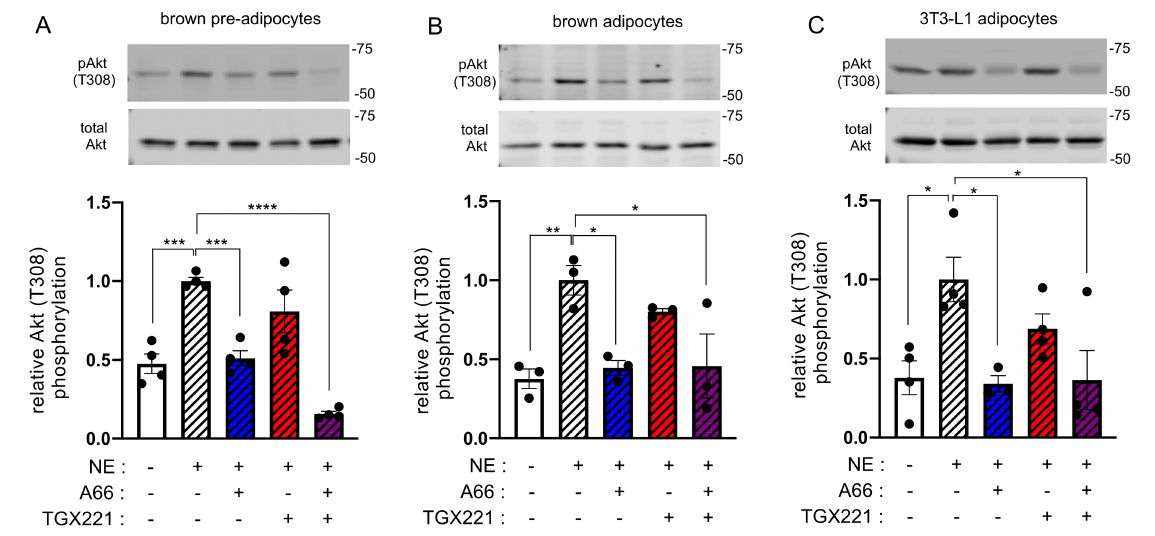
Figure 4. p110 α is the principal PI3K isoform engaged in β -adrenergic signalling in adipocytes. Brown pre-adipocytes ( A ) or differentiated adipocytes ( B ) or differentiated 3T3-L1 adipocytes ( C ) were treated with A66 (1 µ M, blue graph bars) or TGX221 (0.5 µ M, red graph bars) or a combination of both inhibitors (purple graph bars) followed by stimulation with 1 µ M of norepinephrine (NE, striped graph bars) for 15 min at 37 ◦ C. Levels of Akt T308 phosphorylation were determined by immunoblot analysis. Phosphorylation levels were normalised to total Akt levels detected in a second blot performed in parallel using the same lysates. Representative immunoblots and corresponding bar graphs with pooled data from three or four ( n = 3–4) independent experiments are shown. Data are presented as mean ± SEM. Statistical analysis was performed by one-way ANOVA with Dunnett’s multiple comparisons test between vehicle-treated NE-stimulated and all other samples. * p < 0.05; ** p < 0.01; *** p < 0.001; **** p <